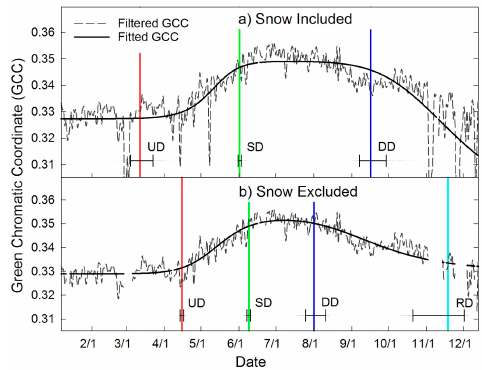
Figure A2. Phenology analyses of an individual pinyon canopy. ( a ) Image set contained all filtered images, including images with snow; ( b ) Image set contained the same images as (a), with all snow images removed.